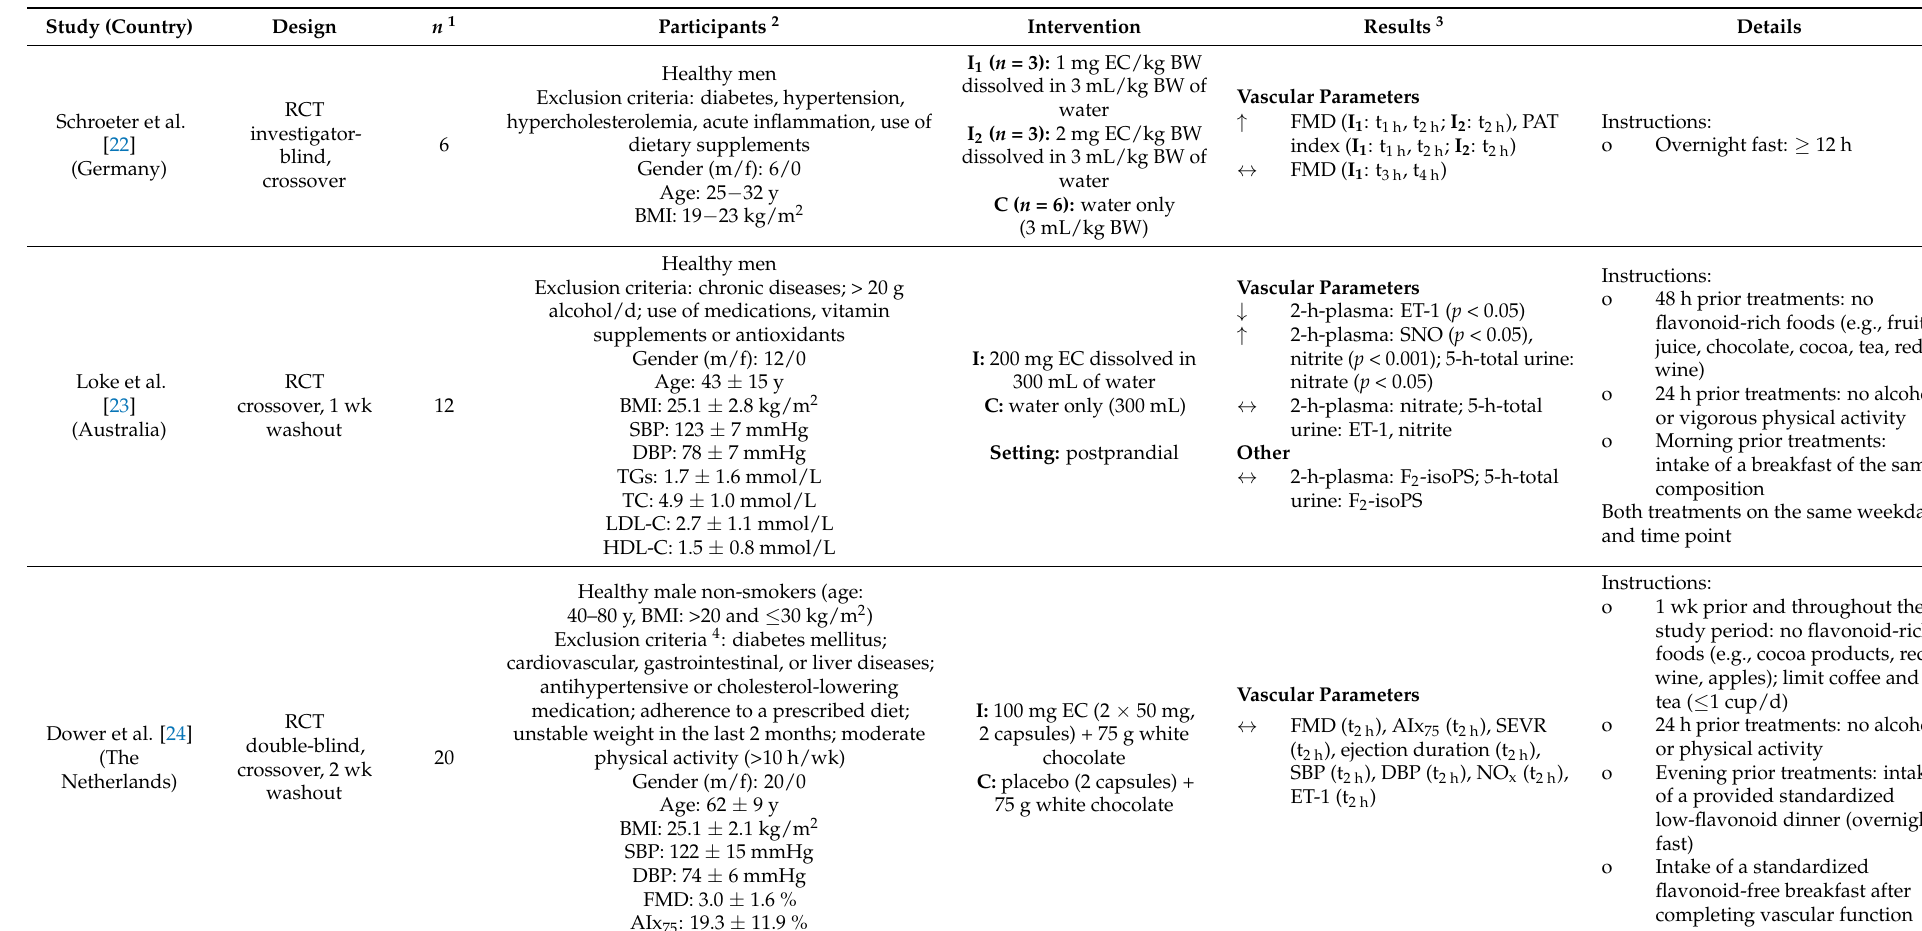
Table 1. Effect of an acute (–)-epicatechin intake on cardiometabolic parameters—results from randomized controlled